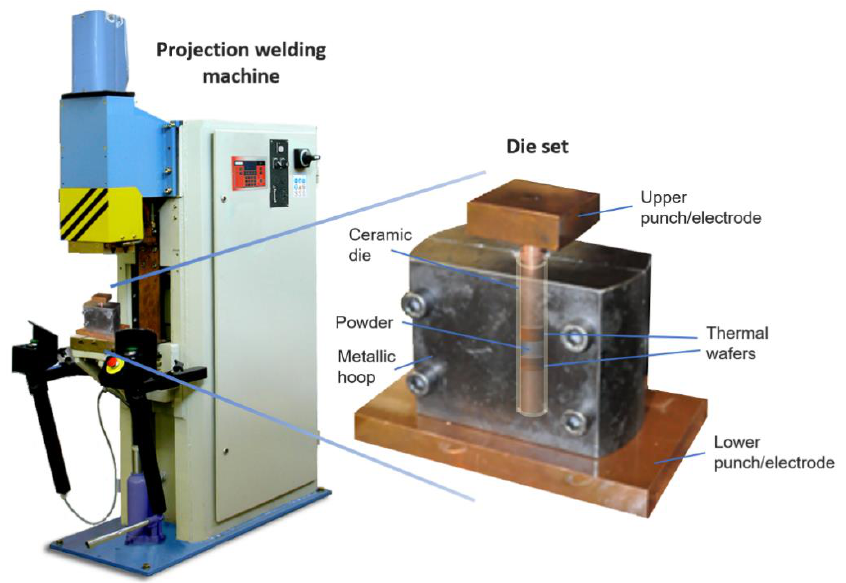
Figure 1. Electrical resistance welding equipment adapted to act as the medium-frequency electrical resistance sintering (MF-ERS) equipment, and detail of the die and electrodes/punches set employed in the experiments (a superimposed image shows the internal arrangement of the components).